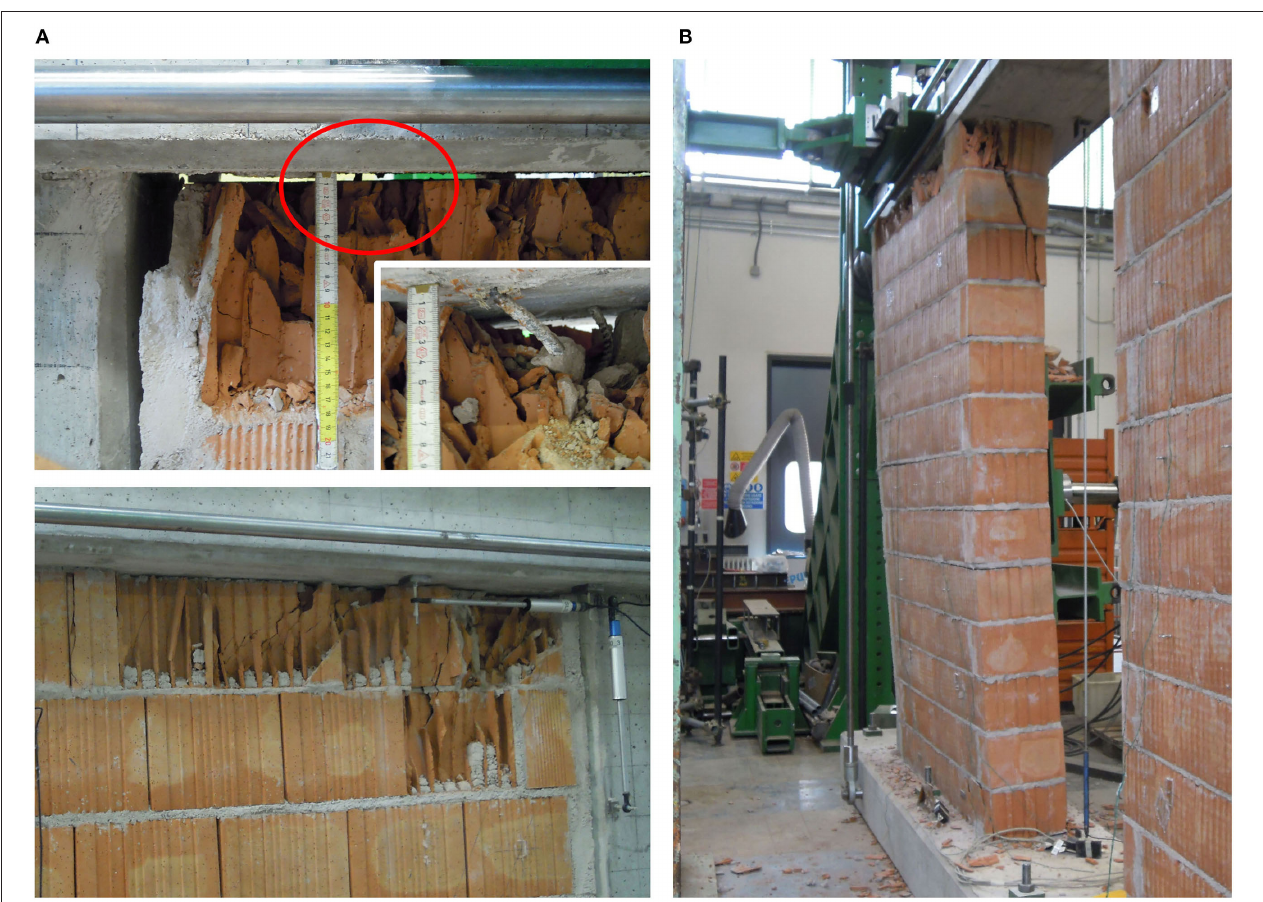
FIGURE 14 | 7-PRIU: effect of crushing at the top course, with a view on a vertical reinforcement bar (A) ; effect of global overturning due to the weak top course (B) .